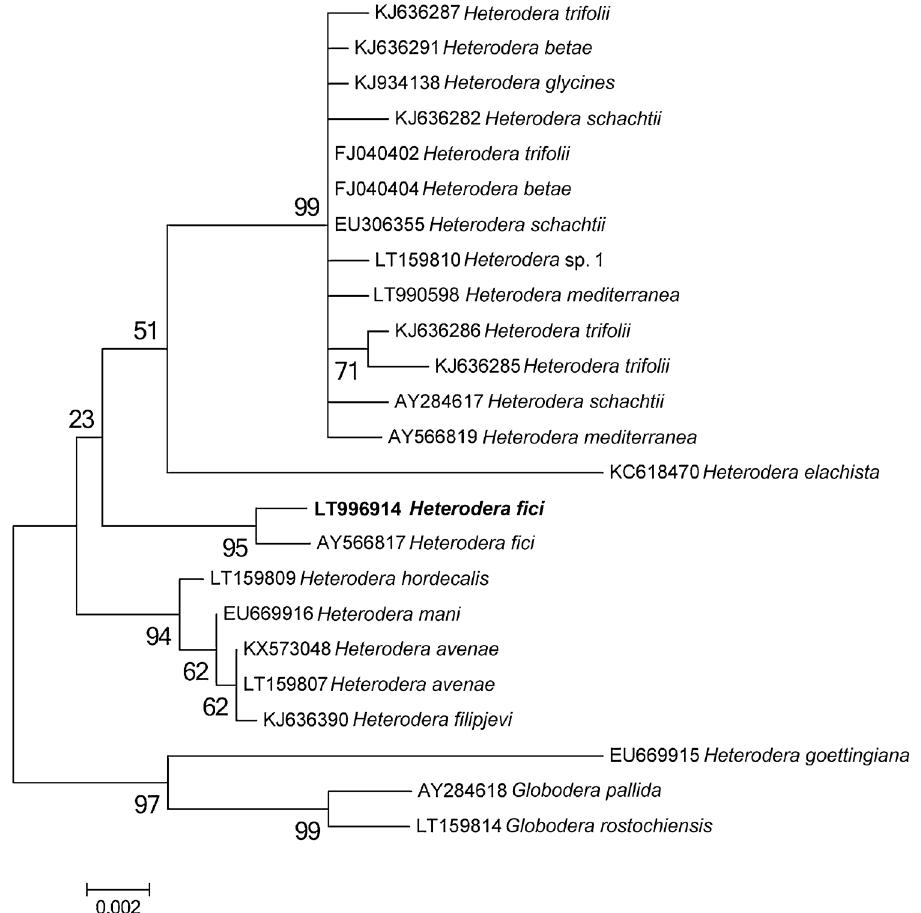
Figure 8. Phylogenetic trees of the 18S rRNA gene of Heterodera fici and the closest species. Sequences were analysed using the Maximum Likelihood method. Numbers at nodes indicate bootstrap